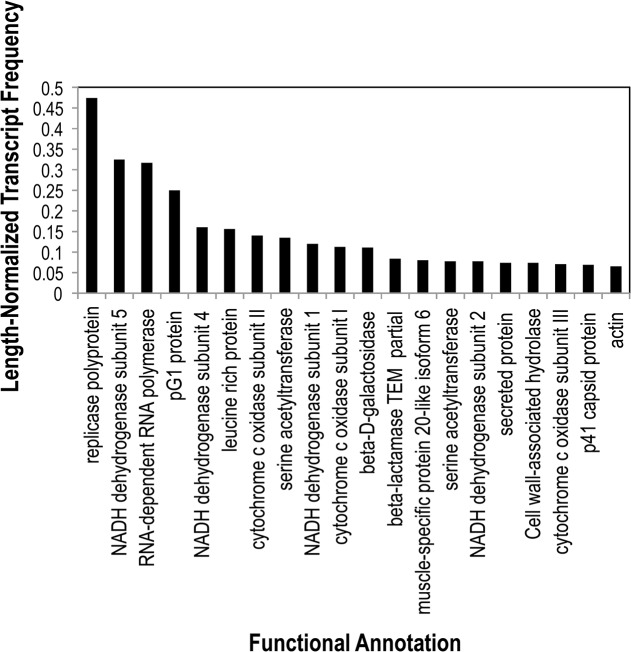
Twenty most highly expressed functional annotations represented in sea star transcriptomes across all 4 libraries.Functional annotations were performed by BLASTx comparison against the non-redundant database at NCBI. Transcript frequencies were normalized by dividing percentage of reads associated with each annotation by contig length.